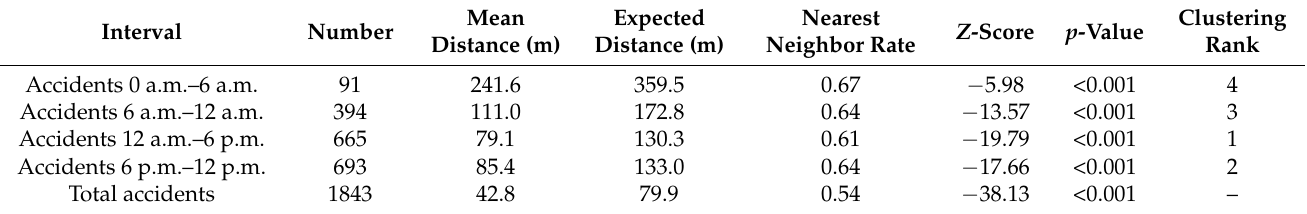
Table 2. Results of a nearest neighbor test by time